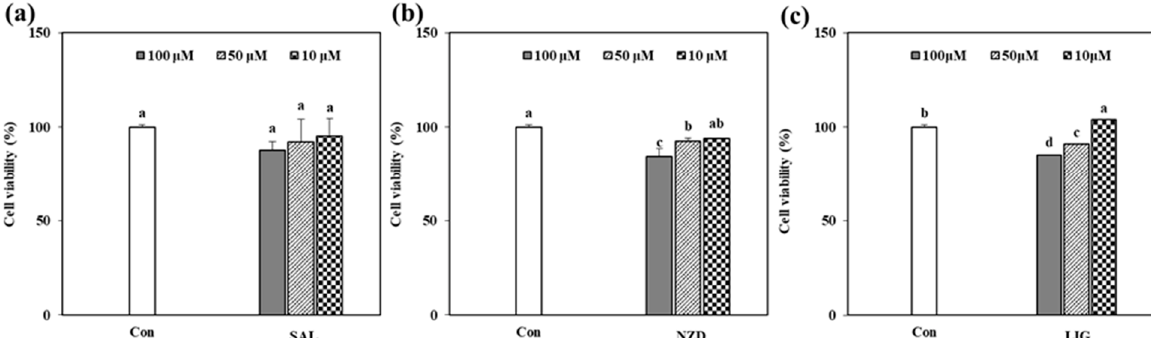
Figure 2. Effect of SAL (a), NZD (b) and LIG (c) on viability of HT1080 cells. The data are presented as mean ± standard deviation of three independent experiments for each compound (Con: untreated cells). a-d Means with different letters indicate statistically significant difference at p < 0.05 level, as assessed by Duncan’s multiple range test.